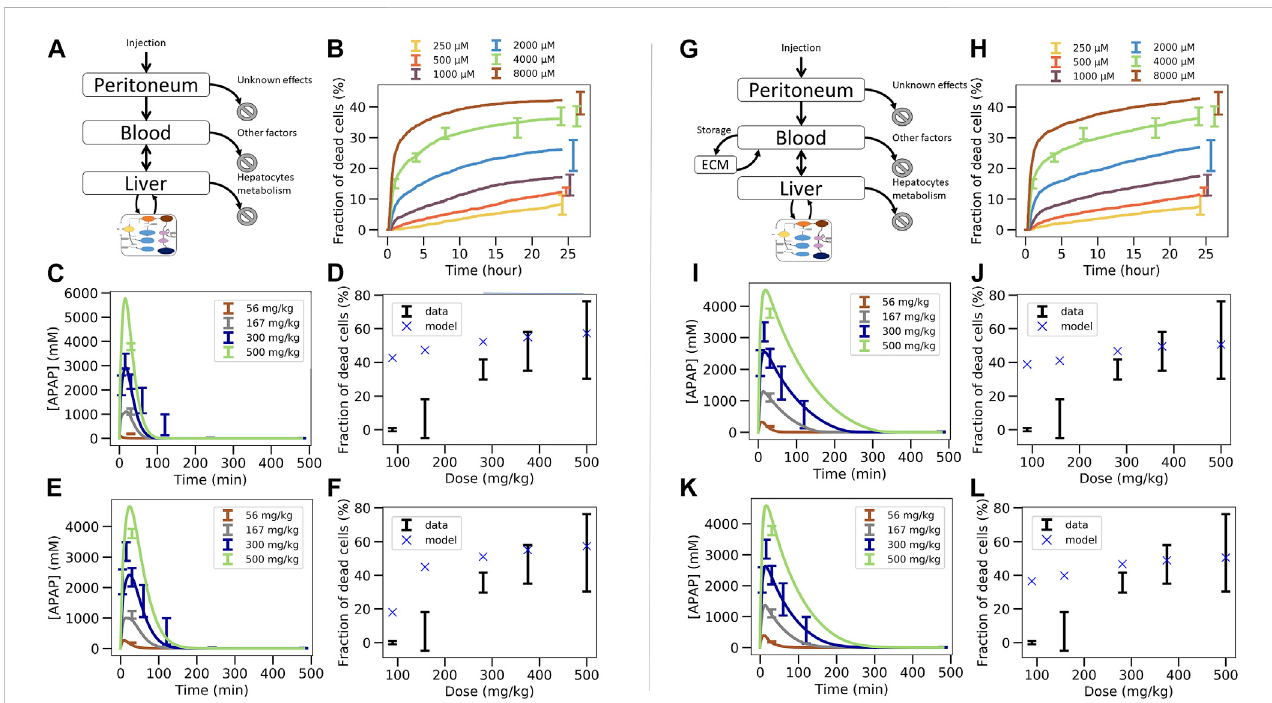
FIGURE 5 TwostepscoupledPK/PDmodelstrategy. (A – F) Invivo modelcomposedofliver,blood,peritonealcavityandintracellularPDmodel. (A) modelstructure of in vivo model, (B) fi t of the intracellular PD model on in vitro toxicity data for random seed 13 ( cf. Figure 4B), (C) fi t of the PK/PD in vivo model extracellular parameters on APAP blood in vivo concentration data keeping the permeability as its in vitro value, (D) extrapolation to in vivo toxicity, (E) fi t of the PK/PD in vivo model extracellular parameters and effective permeability in vivo on APAP blood in vivo concentration data (E) , (F) extrapolation to in vivo toxicity. (G – L) In vivo model of (A) – (F) extended byan “ ECM ” compartmentrepresenting thespaceofDisse. (G) Coupled PK/PD model scheme withassumedstorage from ECM, (H) fi t of the in vitro -PD model on in vitro toxicity data for random seed 25 that lead to lower permeability, (H) fi t of the PK/PD in vivo model extracellular parameters on APAP blood in vivo concentration data usingrandom seed 25and assumed ECM storage, (I) extrapolationto in vivo toxicity, (J) , fi t of the PK/PD in vivo model with additional ECM storage hypothesis, (K) and with extracellular parameters and effective permeability in vivo on APAP blood in vivo concentration data for random seed 25, (K) extrapolation to in vivo toxicity (L)